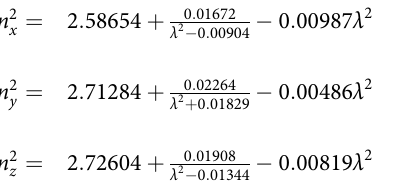
plane are evaluated to be 310 and 322 nm (Fig. 4d), respectively.